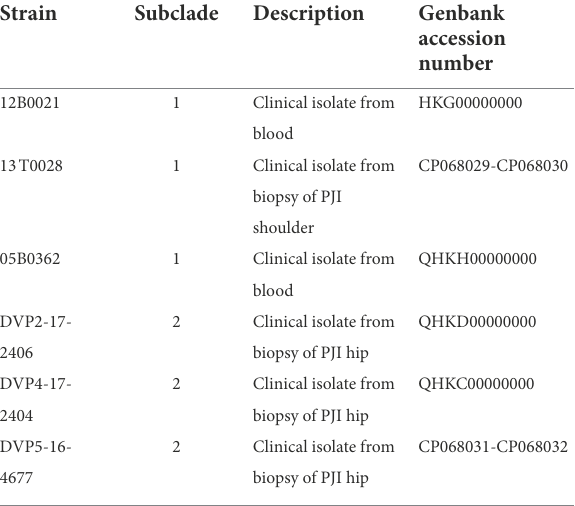
TABLE 1 Information about the S. saccharolyticus strains used in this study. Strain